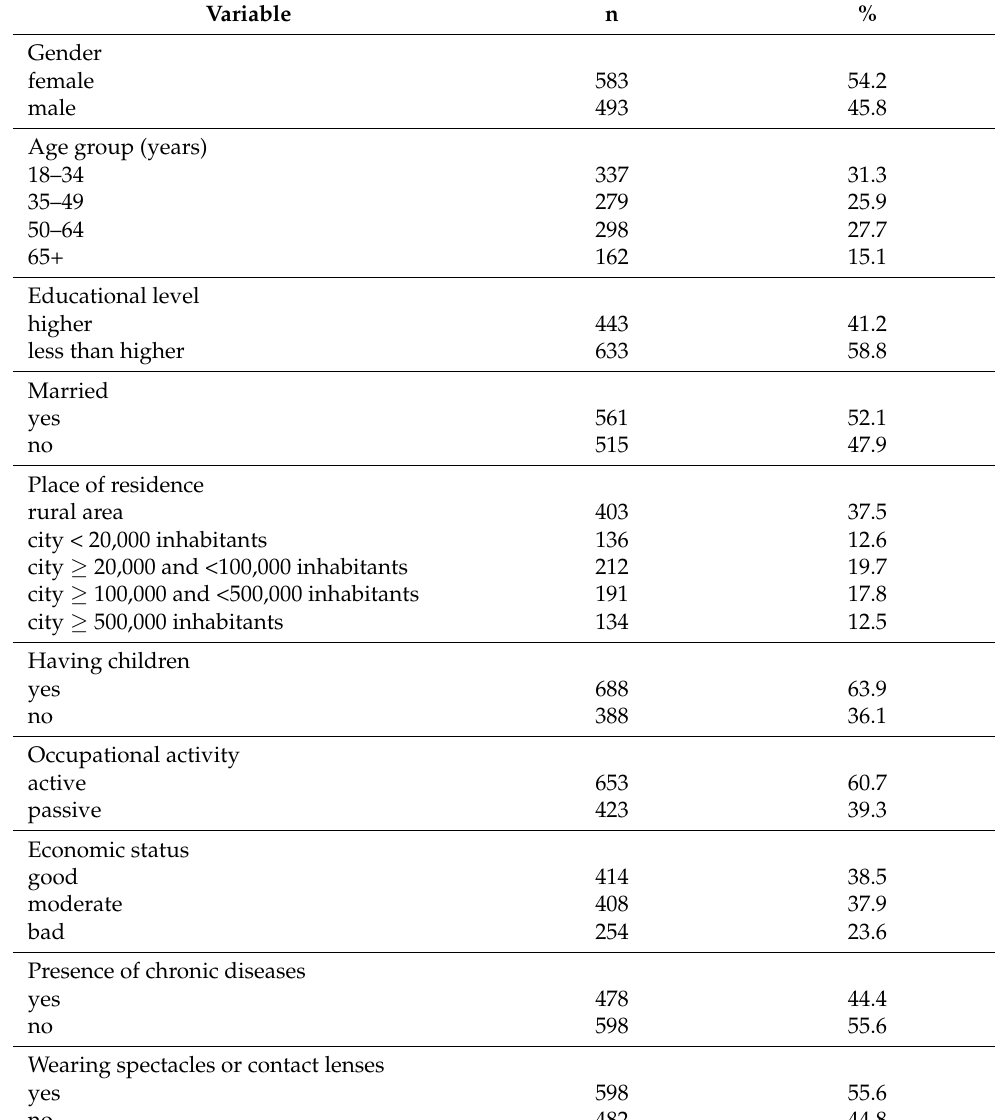
Table 1. Characteristics of the study population (n =